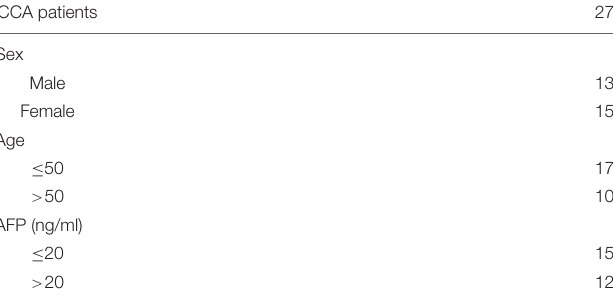
Table 1 Primers used in qRT-PCR